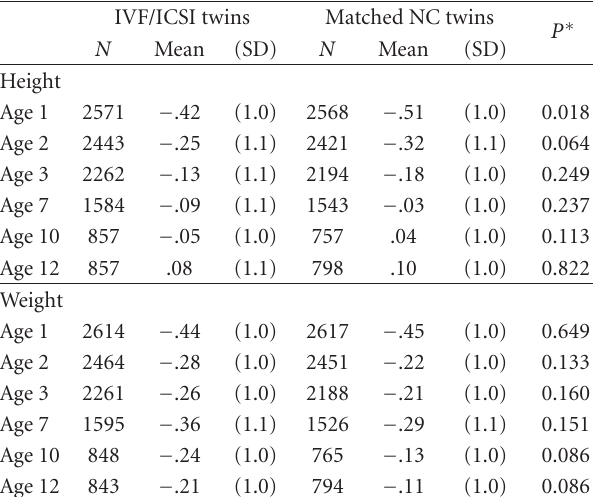
Table 4: SDS height and weight for ages 1 to 12 years for IVF/ICSI twins and matched NC